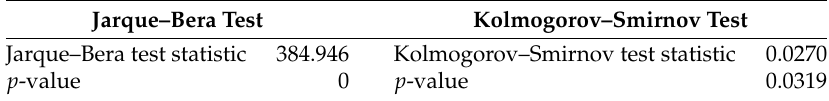
Figure A4. The empirical and normal distributions of standardized residuals. ( a ) Density plots; ( b ) CDF plots. Table A8. Normality tests for standardized residuals ˆ ν t .